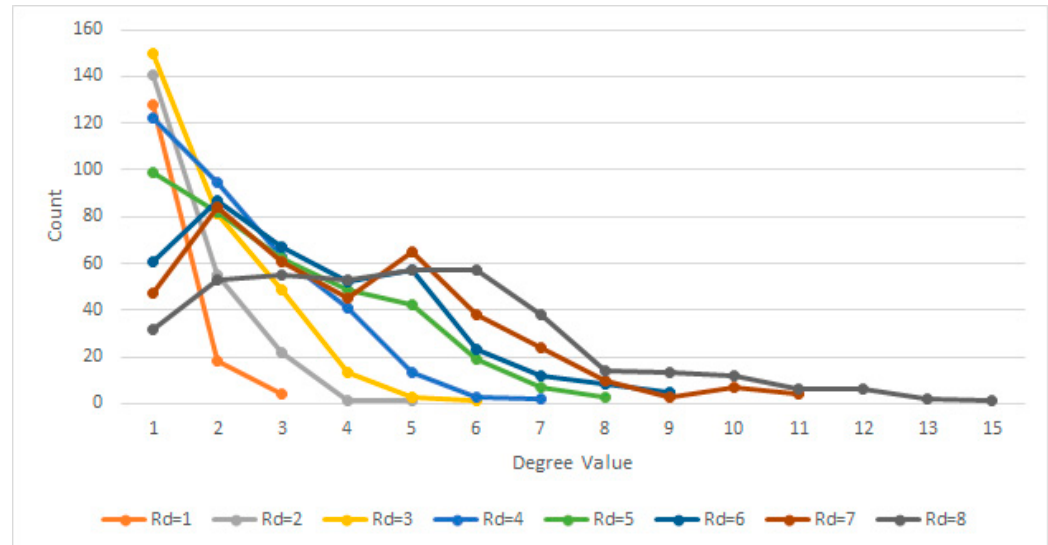
Figure 3. Degree distributions for various Rd.